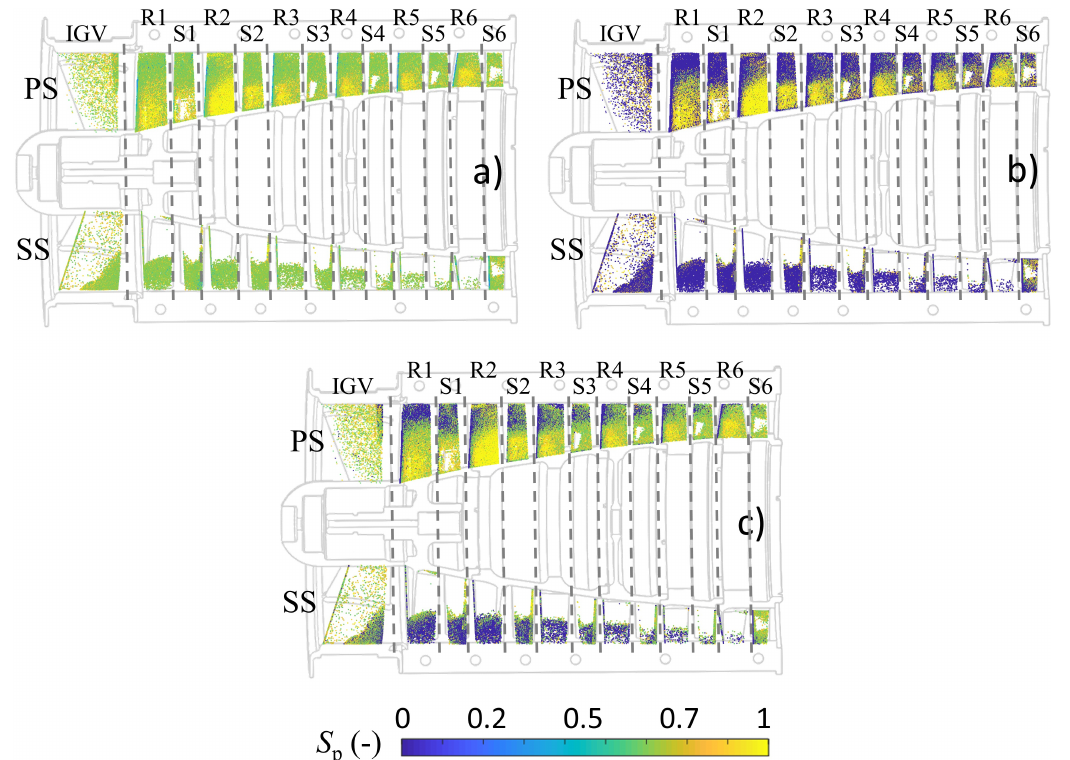
Figure 11. Sticking probability calculated over the compressor stages: ( a ) silica carbide adhesion (SCA) model; ( b ) SCA model with critical impact angle in dry conditions; and ( c ) SCA model with critical impact angle in wet